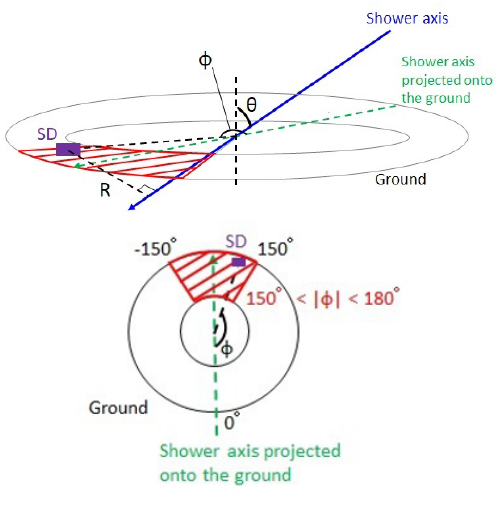
Figure 7. The definition of geometrical parameters of each SD. (Figure from